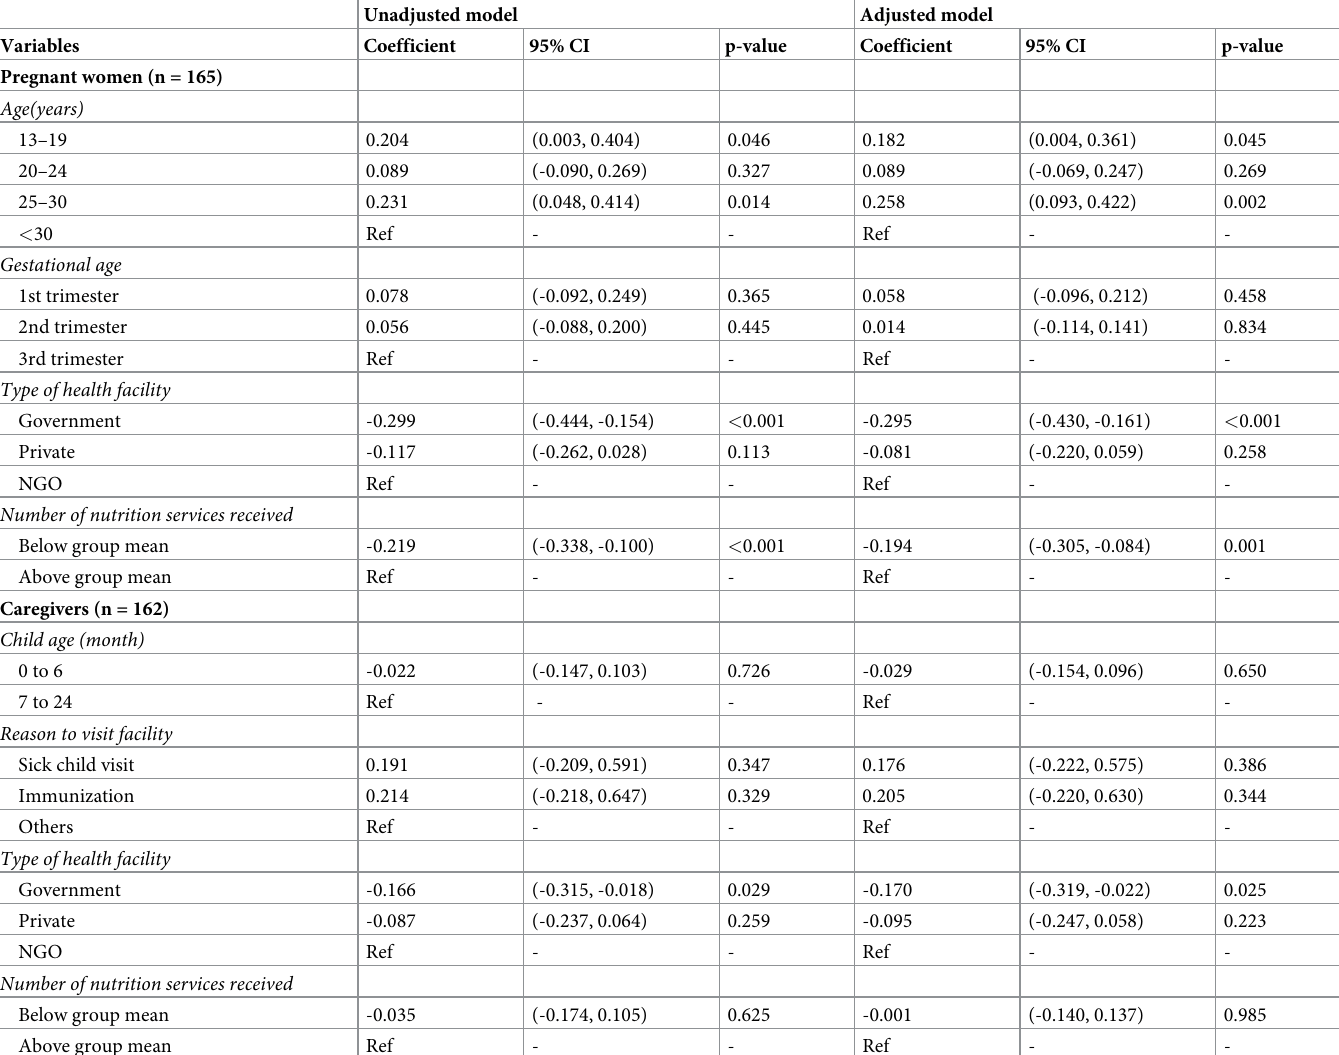
Table 7. Factors associated with satisfaction score related to health service utilization among pregnant women and caregivers of young